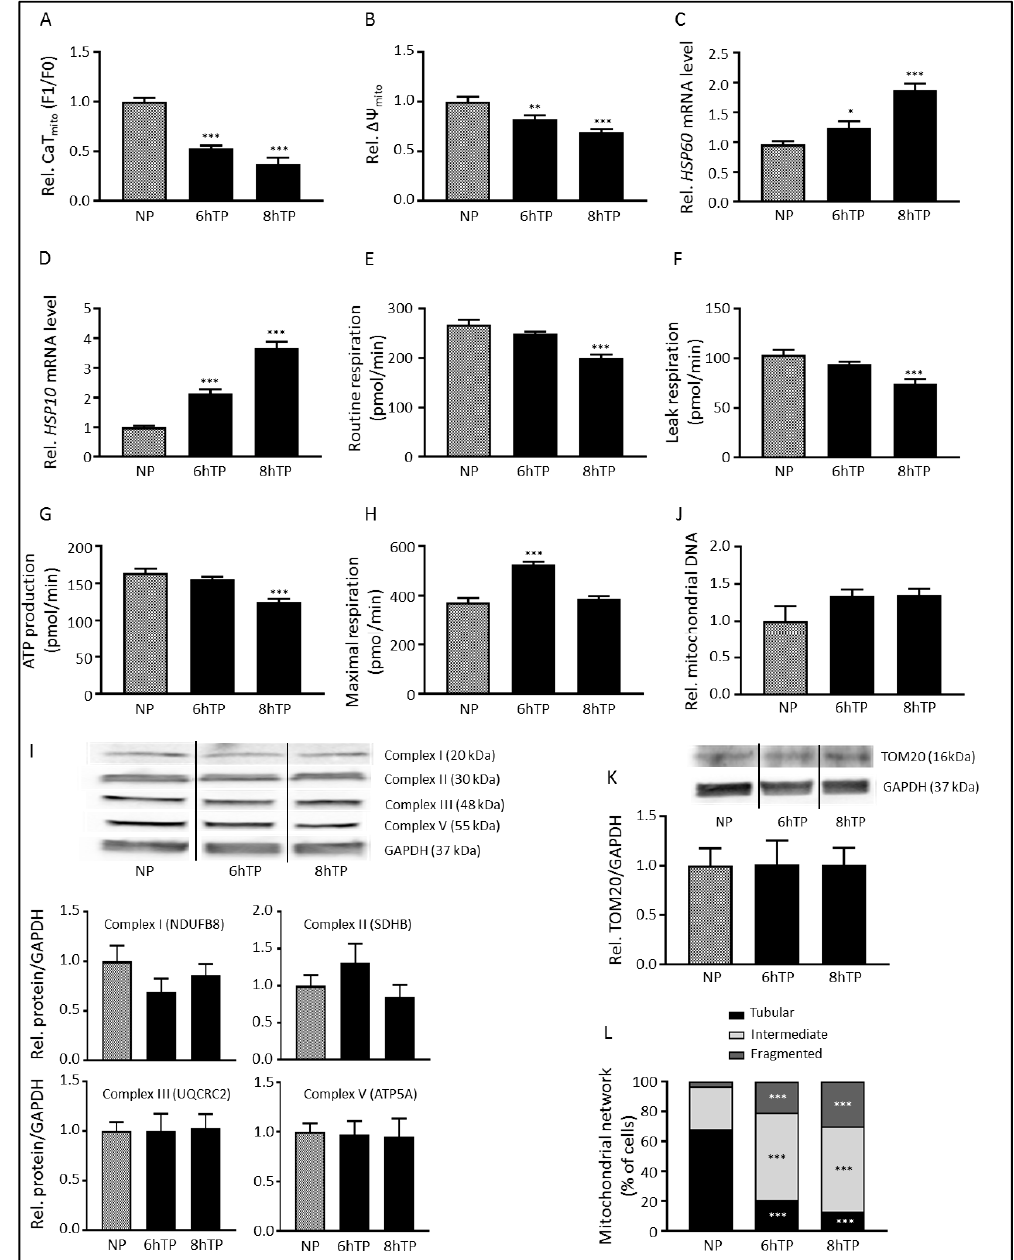
Figure 1. Tachypacing induces mitochondrial dysfunction and stress. ( A ) Quantified data of mitochondrial calcium transient (CaT mito ) amplitudes of HL-1 atrial cardiomyocytes during normal-pacing (NP) and tachypacing (TP). ( B ) Mitochondrial membrane potential during NP and TP. Quantitative real-time PCR of mitochondrial stress markers ( C ) HSP60 and ( D ) HSP10 in response to NP and TP. The oxygen consumption rate showing ( E ) routine respiration, ( F ) leak respiration, ( G ) ATP production and ( H ) maximal respiration during NP and TP. ( I ) Top panel represent Western blot of respiratory chain complexes I, II, III and V. Lower panels reveal quantified data of the respiratory chain complexes normalized for GAPDH. ( J ) No changes in mitochondrial DNA during TP compared to NP. ( K ) Top panel represent Western blot and lower panel reveal quantified data of TOM20 normalized for GAPDH. ( L ) Transition of the mitochondrial network from tubular to fragmented from NP to TP. * p < 0.05, ** p < 0.01, *** p < 0.001 vs. NP.